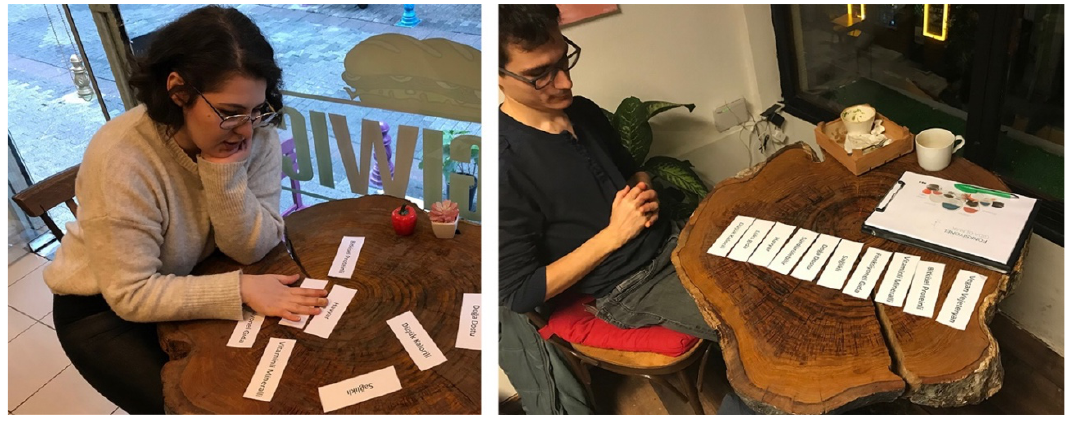
Figure 7: Vegan Restaurant and Market visits